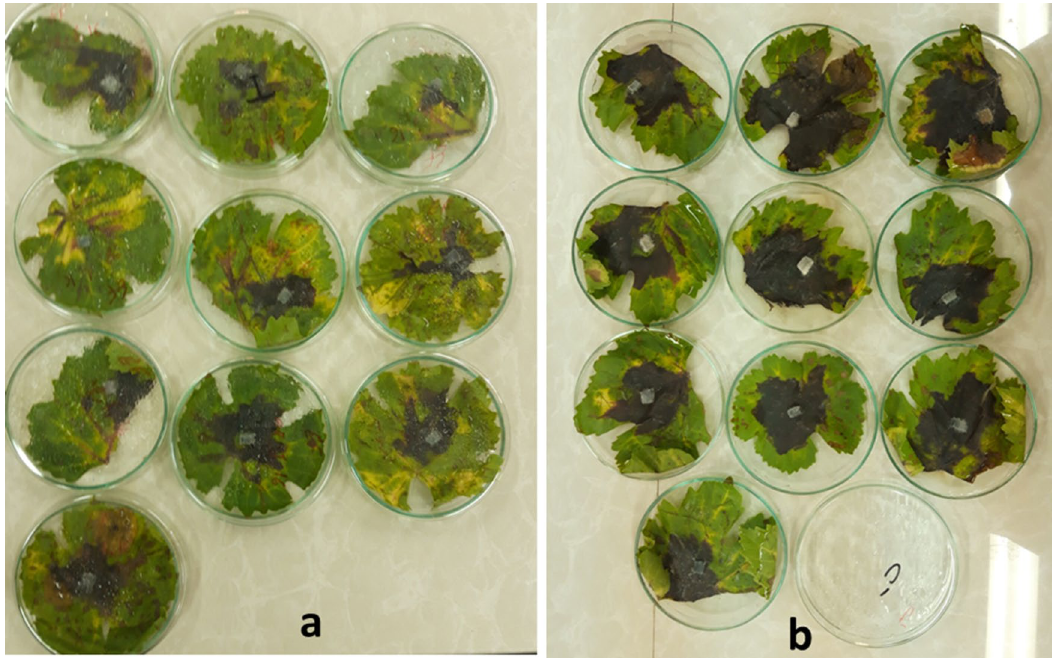
Figure 4. Bioassay of pFGC-TEF-d effects on necrosis 8 dpi by L. theobromae in grapevine (Bidaneh Sefid) leaves. ( a ) Leaves transiently expressed pFGC-TEF-d as a treatment and ( b ) control leaves expressing empty plasmid ( pFGC 5941).